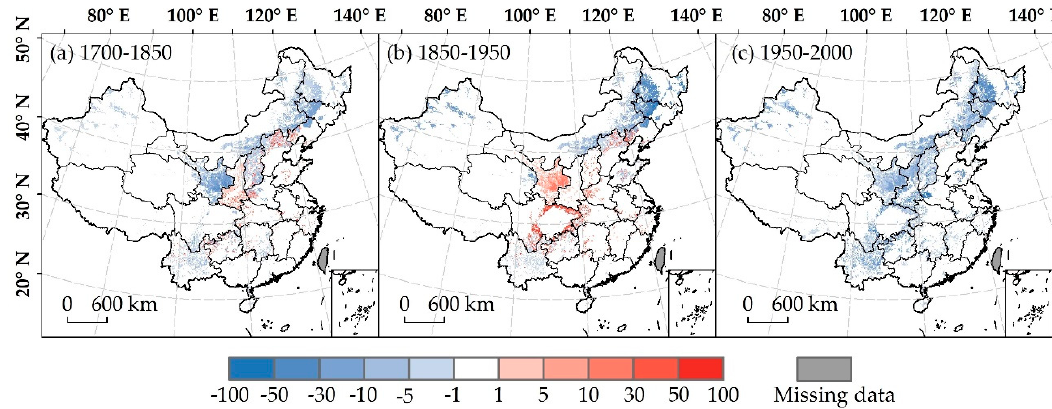
Figure 6. Net changes in grassland cover in China from 1700 to 2000.